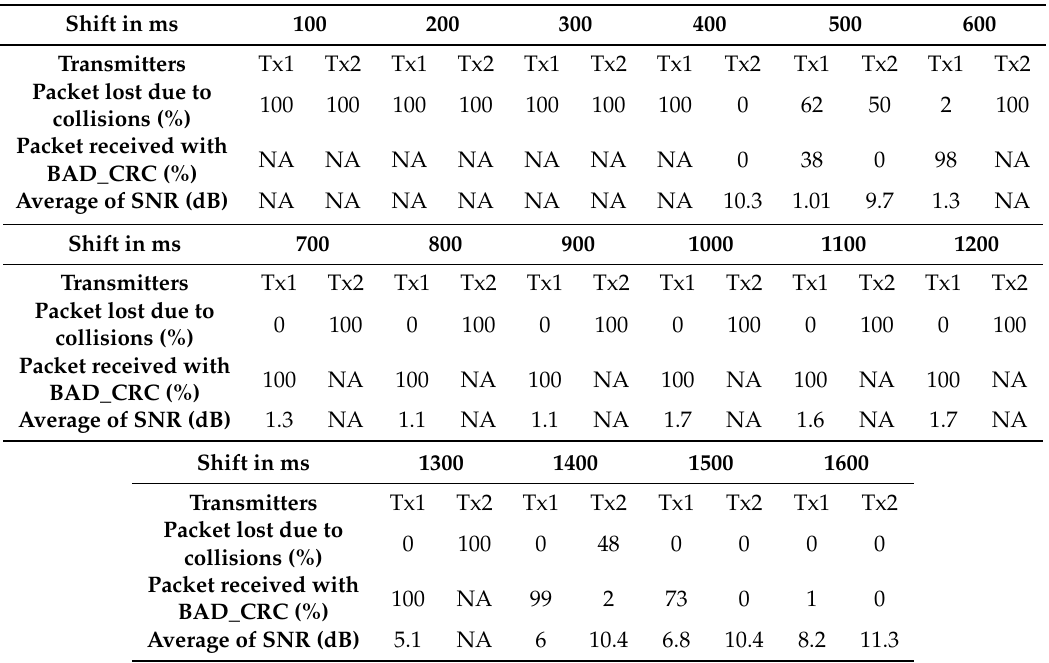
Table 4. Statistics for collided packets for the case when the interferer has a 12 dB higher RSSI than the interfered transmission for the first setting from Table 1. NA stands for Not Available.